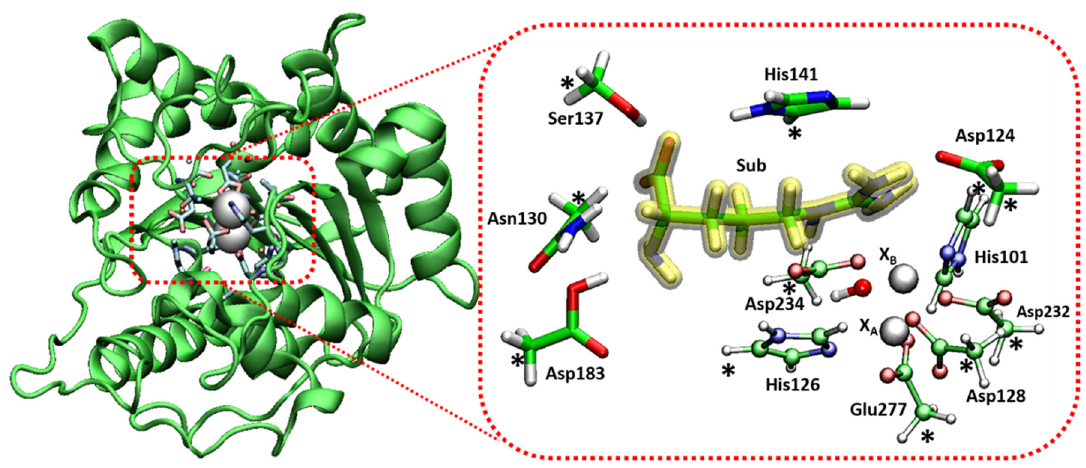
Figure 8. QM cluster model of X A -X B arginase (X A / X B = Co 2 + , Mn 2 + ) active site. Stars indicate the frozen atoms during the optimizations.